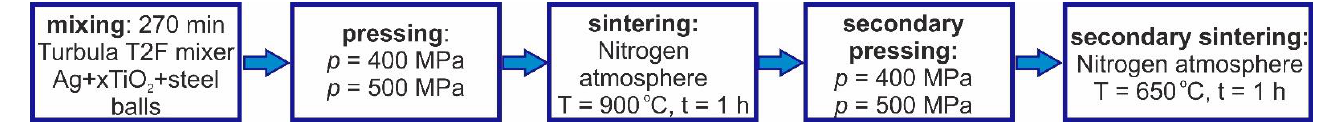
Figure 2. Scheme of Ag–xTiO 2 composite manufacturing process. Microstructure studies were carried out on the sinters made in this way using a Hitachi Su 70 scanning electron microscope (Hitachi, Tokyo, Japan). The micrographs were taken during operation of the detector collecting secondary electrons (SE) or backscattered electrons (BSE). Additionally, the chemical composition was analyzed using the wavelength- dispersive X-ray spectroscopy (WDS) method (Thermo Fisher Scientific, Waltham, MA, USA) and the phase composition was analyzed using a BRUKER X-ray diffractometer with a Co K α = 0.179 nm (1.79 Å) cobalt lamp (D8 Advance, Bruker, Karlsruhe, Germany). Observations of the microstructure of the samples in the submicron range were made using a JEOL JEM-2010 ARP transmission electron microscope (Jeol Ltd., Tokyo, Japan). The specimens for observation were prepared by the ion thinning method using a Precision Ion Polishing System (PIPS) device by Gatan (Gatan, Inc., Pleasanton, CA, 94588,